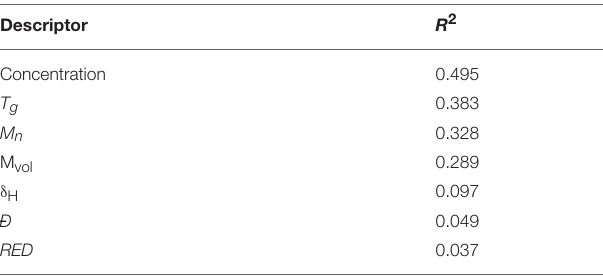
TABLE 7 | Linear correlation coefficient R ² of each descriptor one by one on unsaturated polyester viscosity in solution.